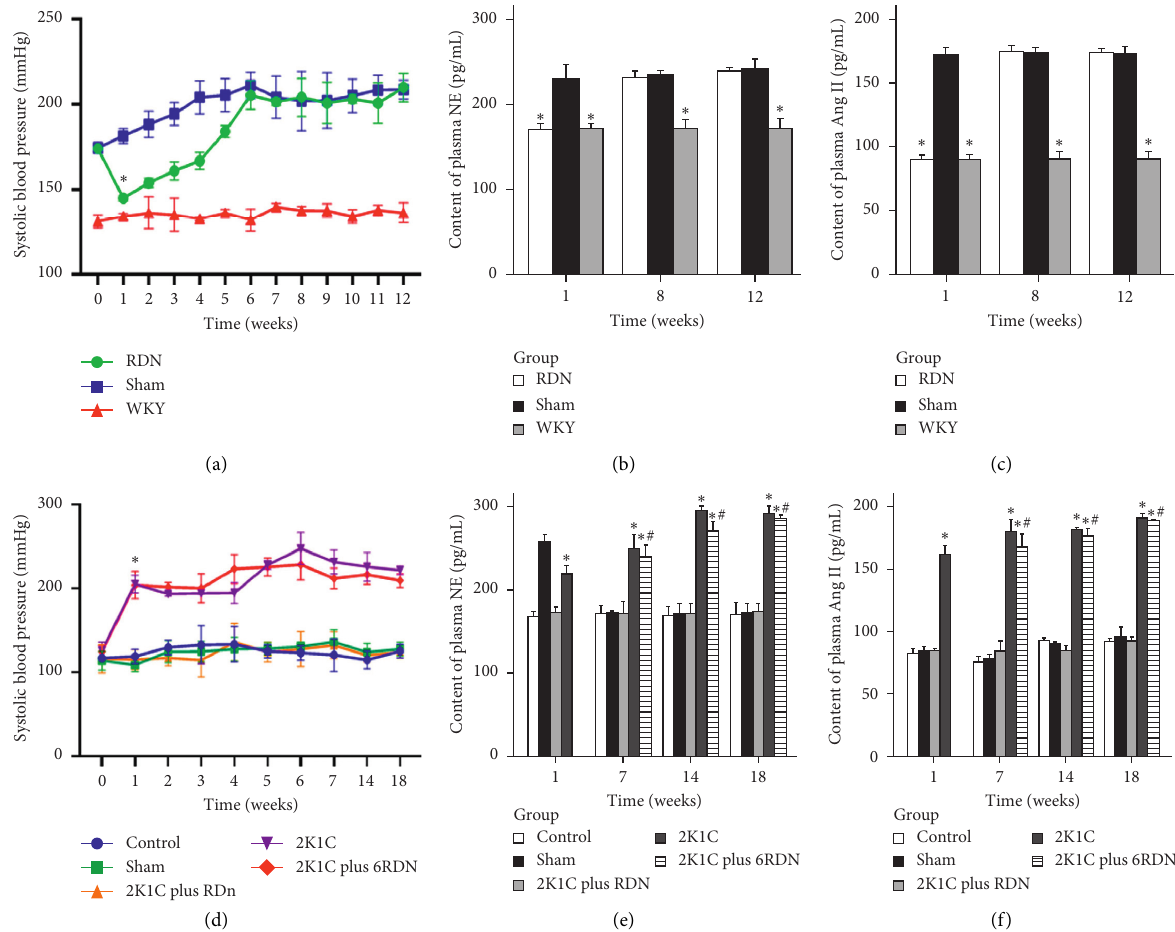
Figure 2: The comparison of systolic blood pressure and neurohumoral activation in SHR and SD rats. ∗ p < 0 . 05 versus the control group, sham group, and 2K1C plus RDN group, # p > 0 . 05 versus the 2K1C group.